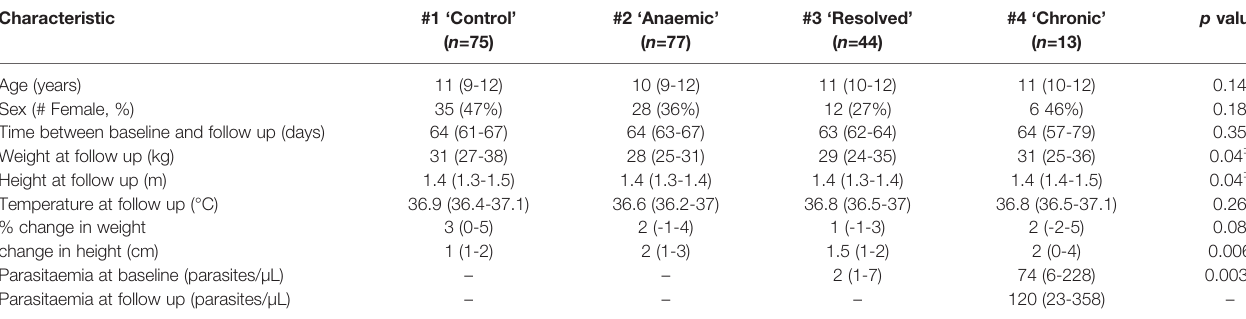
TABLE 1 | Demographics of the study